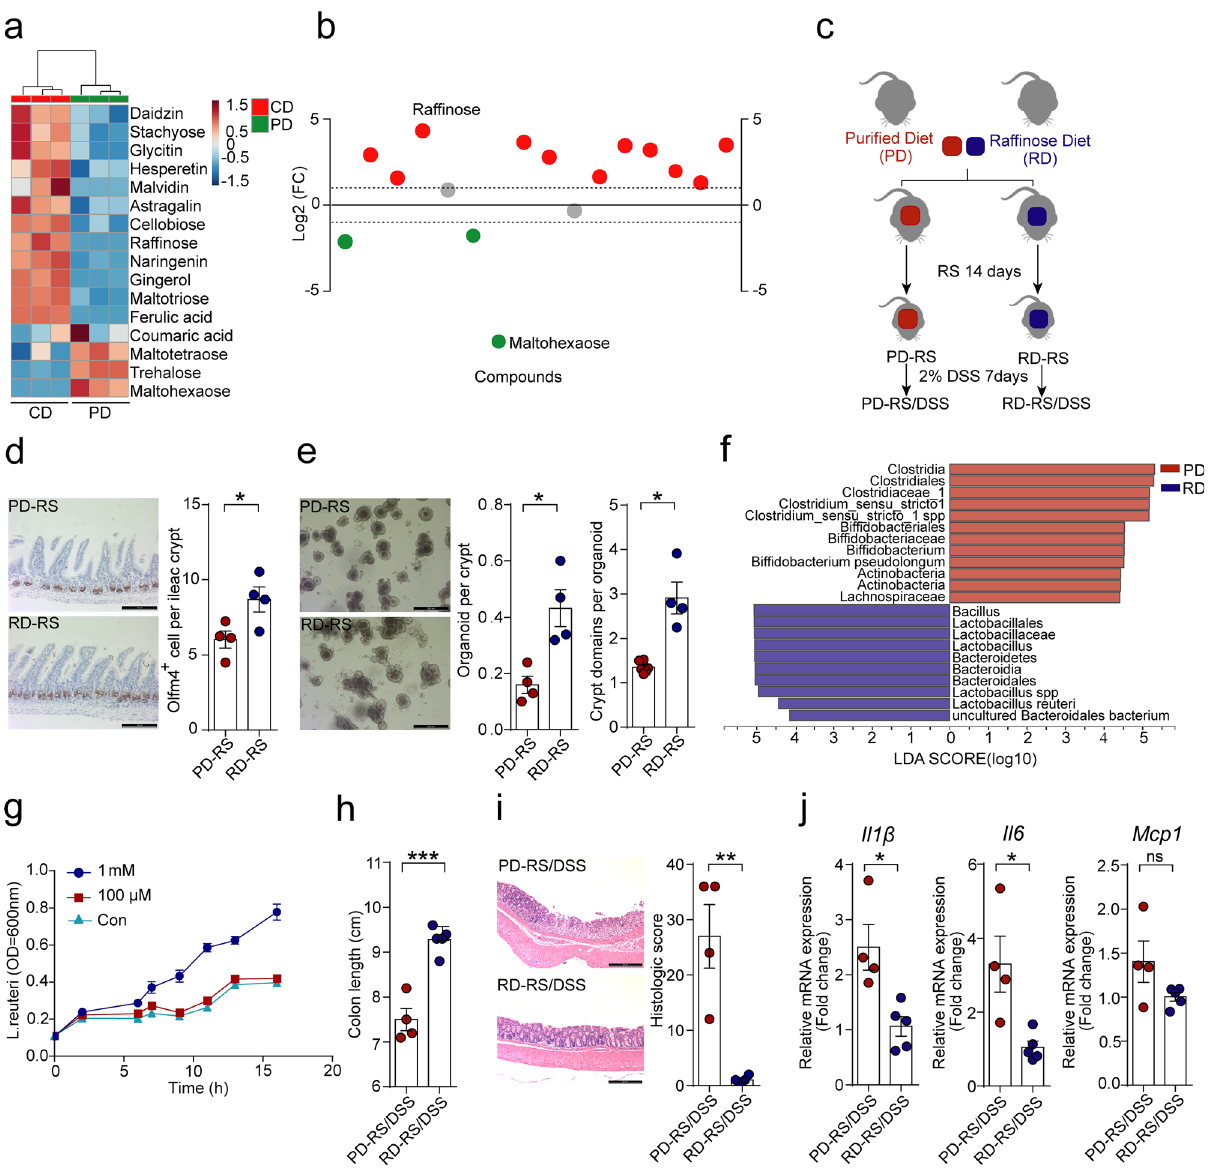
Fig. 4 Raf fi nose underlies diet-dependent epithelial response to stress. a Heatmap showing the different abundance of oligosaccharides and polyphenolic compounds in chow diet (CD) and puri fi ed diet (PD). b Comparison of the Log2-fold changed abundance of oligosaccharides and polyphenolic acid components between CD and PD. Points in red and green represent components enriched in CD and PD, respectively. c Schematic of the experimental design to assess the role of dietary raf fi nose. Mice were fed with PD or PD supplemented with raf fi nose (RD, 100 g/kg diet) during 14 days of restraint stress ( n = 10), and a cohort of mice was subsequently exposed to 2% (wt/vol) DSS for 7 days. d Representative Olfm4 staining images and quanti fi cation of Olfm4-positive cells per crypts in the ileum of mice after 14 days RS. Scale bar: 100 µ m. Data are represented as mean ± SEM for n = 4 biologically independent samples ( p = 0.03). e Representative images of organoids derived from the intestinal crypts of stressed mice fed on PD or RD. The number of organoid per crypt and crypt domain per organoid were compared. Scale bar: 200 µ m. Data are represented as mean ± SEM for n = 4 ( p = 0.009 for organoid per crypt; p = 0.0006 for crypt domain per organoid). f Linear discriminative analysis (LDA) score obtained from LEfSe analysis of fecal microbiota in PD and RD-fed mice after stress. A genus with Kruskal – Wallis ≤ 0.05, as well as LDA > 4, are reported. g In vitro growth curve of L. reuteri with or without raf fi nose supplementation in the culture medium. Data are represented as the average optical density (OD, 600 nm) of culture ± SEM for n = 3. h Colon length of PD and RD-fed mice with DSS-induced colitis. Data are represented as mean ± SEM for n = 4 ( p = 0.0002). i Representative H&E staining images and a histologic score of distal colon section of colitis mice. Scale bar: 200 µ m. Data are represented as mean ± SEM for n = 4 ( p = 0.004). j Relative mRNA expression of Il1 β , Il6 , and Mcp1 in the colon tissue of colitis mice. Data are represented as average fold change ± SEM for PD-RS/DSS group ( n = 4) and RD-RS/DSS group ( n = 5). p = 0.01 for Il1 β ; p = 0.014 for Il6 ; p = 0.1 for Mcp1 .Statistical signi fi cance in d , e , h – j was determined by unpaired two-tailed Student ’ s t -test. ns no signi fi cance. * p < 0.05, ** p < 0.01, *** p < 0.001.